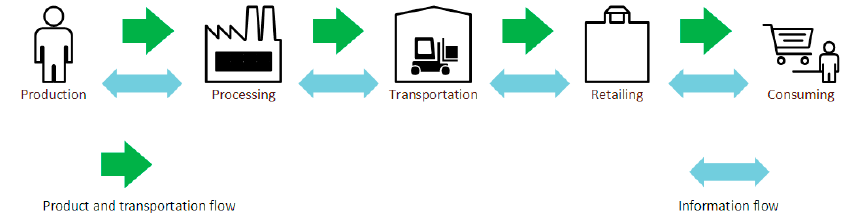
Figure 1. Traceability system product and information flow.